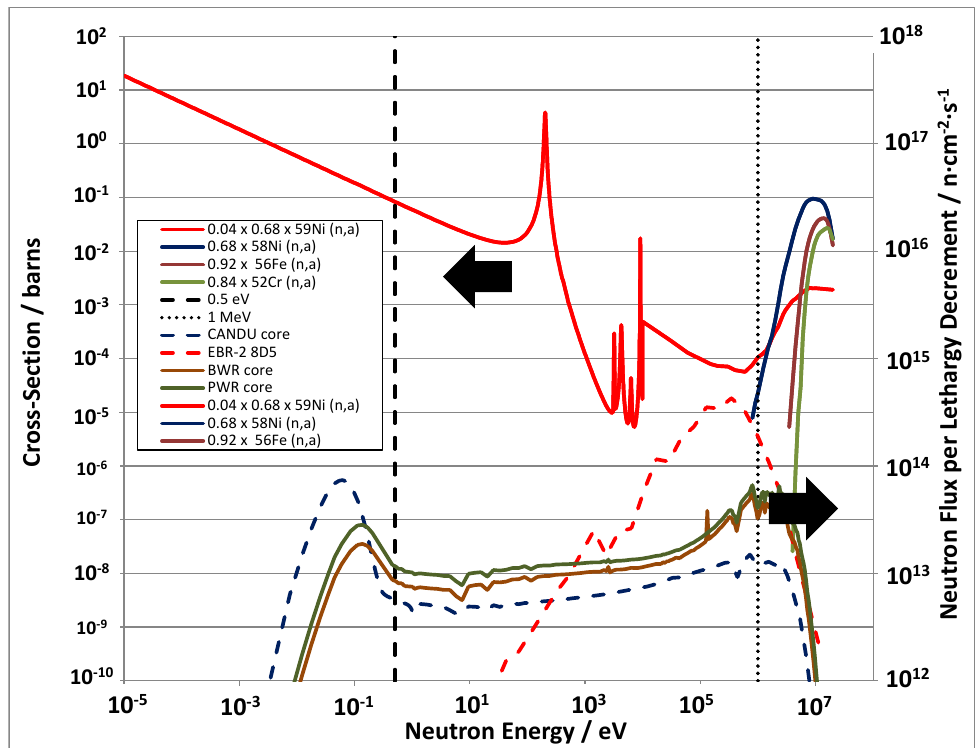
Figure 9. Neutron spectra for PWR, BWR, CANDU and EBR-II reactors (right hand scale) and ( n , α ) cross-sections for the major isotopes of Ni, Fe and Cr scaled for atomic abundance (left hand scale). Also shown is the 59 Ni ( n , α ) reaction cross-section scaled for atomic abundance after 5 years operation in a CANDU core.